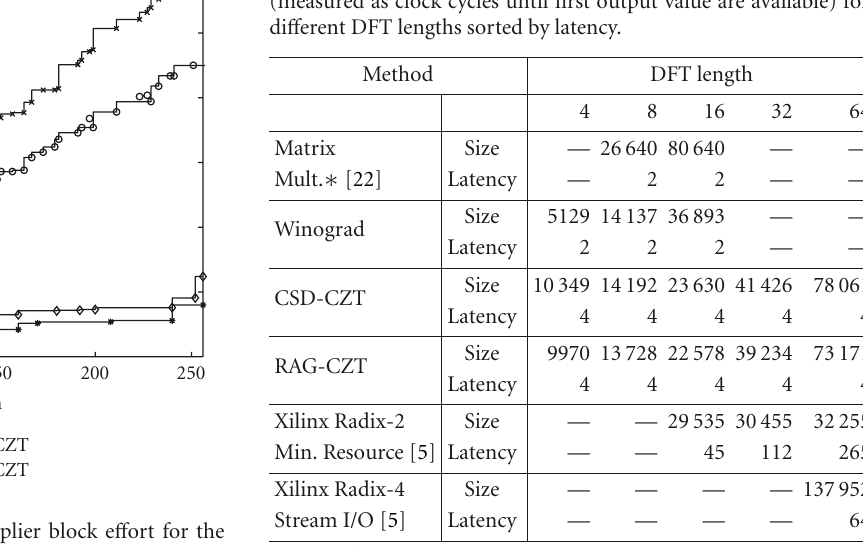
Figure 7: Comparison of complex multiplier block e ff ort for the Rader and CZT algorithm.